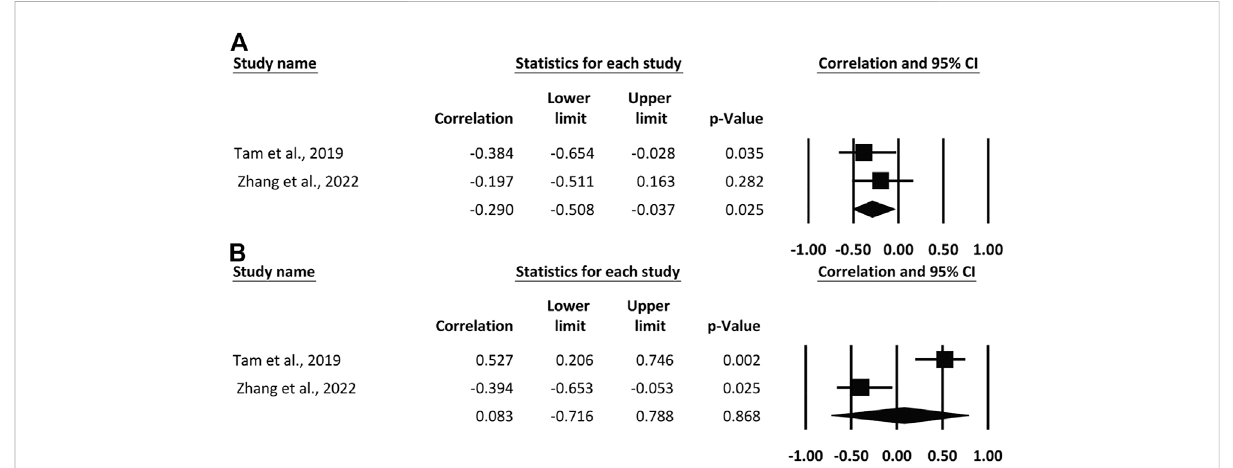
FIGURE 4 Forest plot of the correlation between knee (A) and ankle stiffness (B) and running economy.